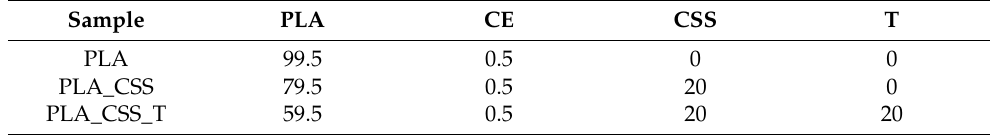
Table 1. Compositions (wt%) and codes of the investigated Table 1. compositions (wt%) and codes of the investigated compounds.